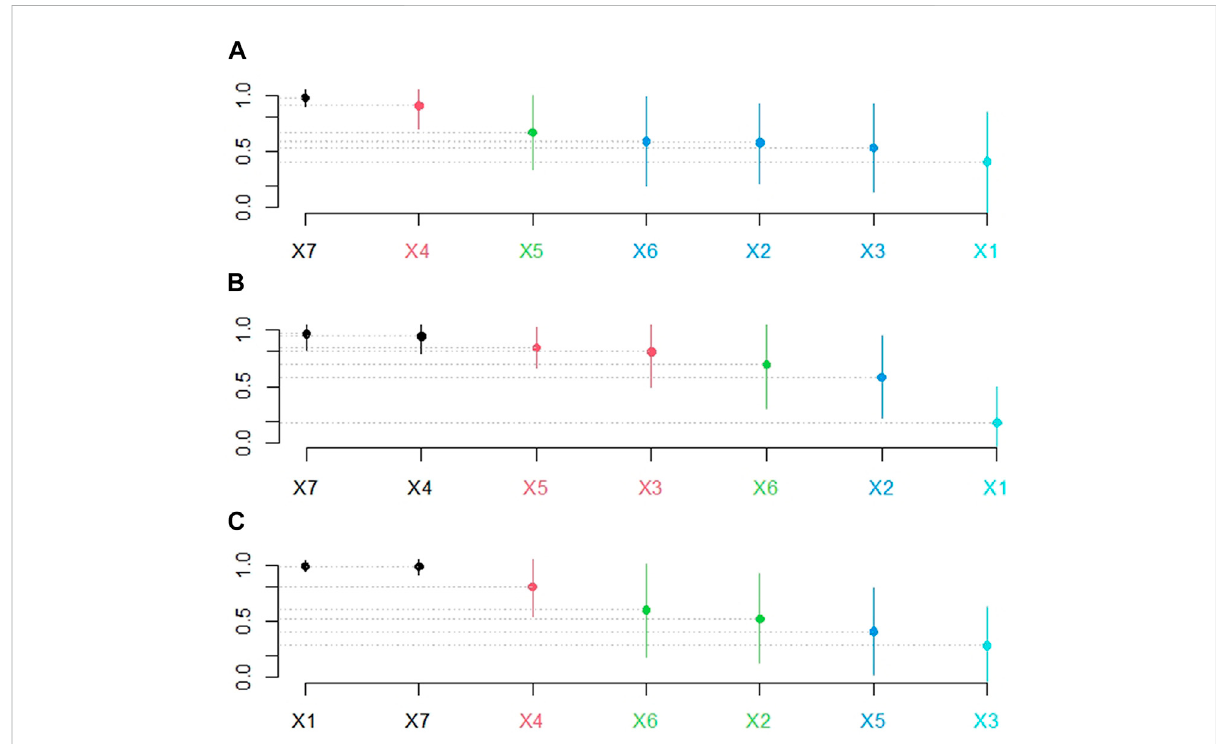
FIGURE 6 Hypothesis test results of RA values. In (A) , (B) , and (C) , X1-X7 denote the fi ve fi xed SV callers, a randomly selected SV caller, and the recommended SV caller in that order. The ordinate represents the recommendation accuracy values. Sub fi gures (A) , (B) , and (C) represent the recommendation schemes with f-measure, precision, and recall as meta-targets, respectively. The points on the bar graph give the average recommendation accuracy values. The length of the bars re fl ects the method ’ s stability. The greater the average recommendation accuracy value, the better the recommendation method; the shorter the bars, the more stable the recommended method. Furthermore, no statistical difference existed between bars of the same color, whereas a signi fi cant difference existed between bars of different